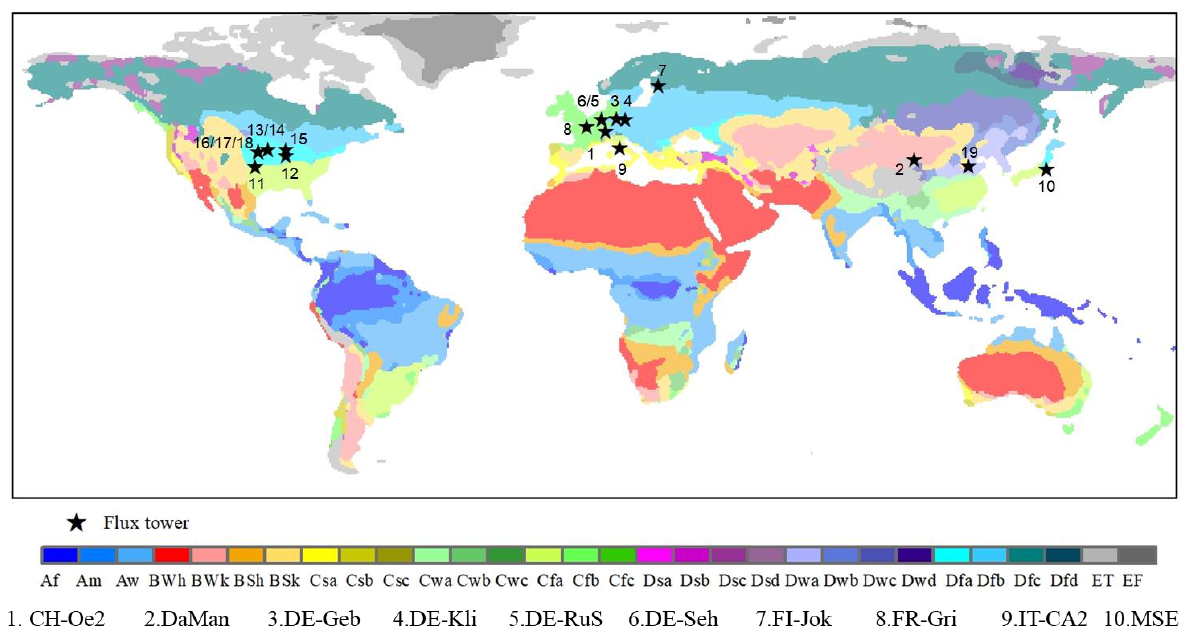
Figure 1. The cropland flux tower sites on a map of Köppen climate zones used in the present study. Codes of climate zones in the color legend are adopted from [56] and given in Table A1 of Appendix A. Numbers with star symbol denote the cropland flux tower sites, ground data from which were used in this study.